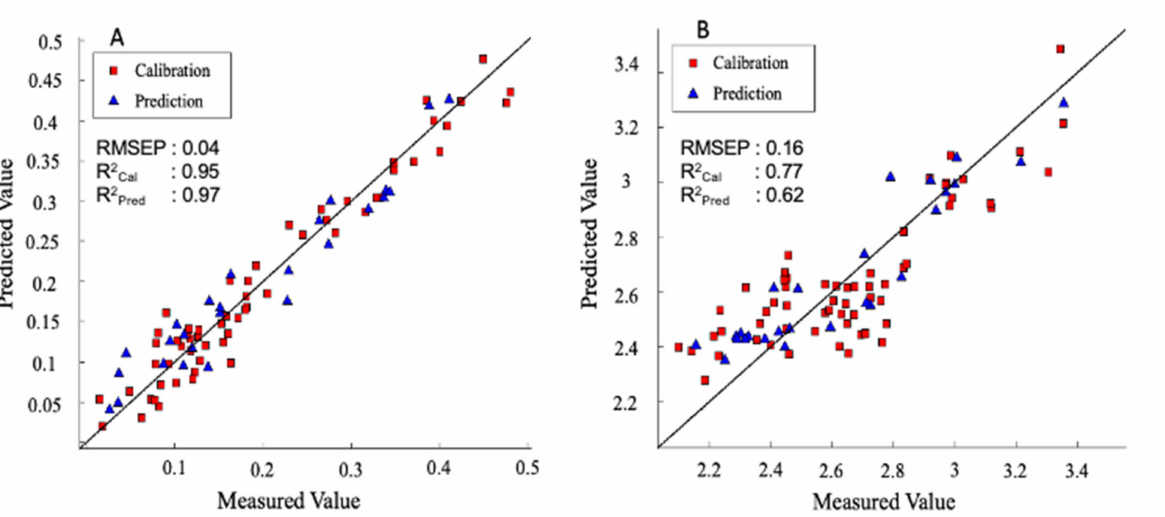
Figure 3. ( A ) AA model (NIR range) and ( B ) Total phenols model (VIS-NIR range): PLS regression plot for predicted vs. measured